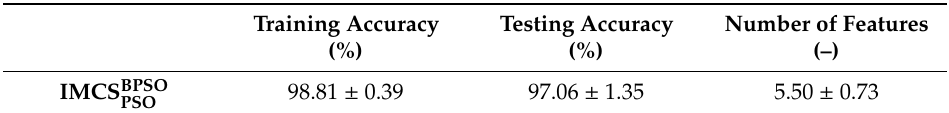
Figure 6. ( a ) Classification on training pool dataset; ( b ) classification on the testing dataset. Table 1. Classification performance of the algorithm over 20 independent runs using a reference MD space based on healthy samples.